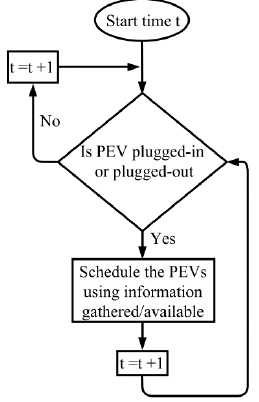
Figure 1. Online plugged-in electric vehicle (PEV) charging scheduling